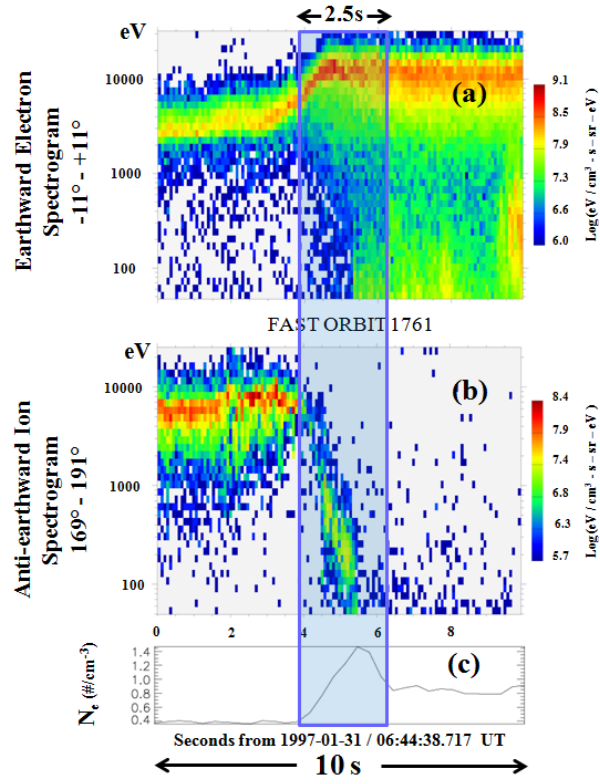
Figure 2. Earthward electron (a) and anti-earthward ion (b) energy fluxes associated with a crossing of a localized double layer. Due to experimental constraints the angular resolution is ± 11 ◦ . The space- craft approaches the DL from the low-potential side. The amount of parallel energy lost by the ions is equal to the amount of en- ergy gained by the electrons: ∼ 8keV. The event takes place inside a density enhancement characterized by a large density jump (c) . The blue shaded region corresponds to the crossing of the parallel electric field illustrated in Fig.